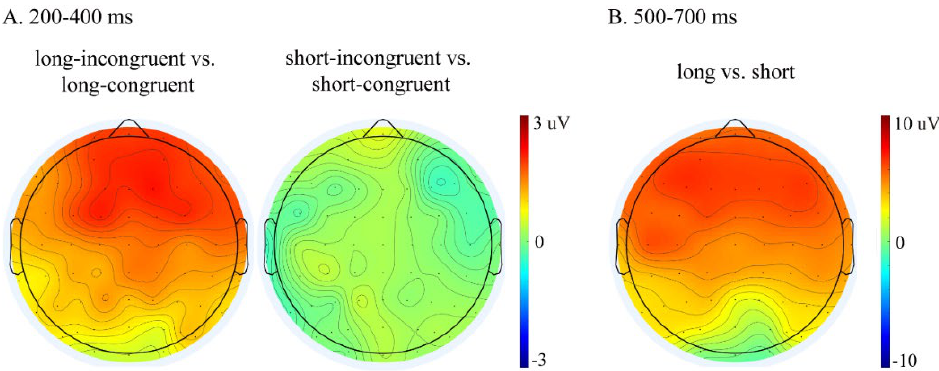
Figure 3. ( A ) Topographies of the difference waveforms determined by subtracting ERPs for the long–congruent conditions from those of the long–incongruent conditions (left) and by subtracting ERPs for the short–congruent conditions from those of the short–incongruent conditions (right) in the 200–400 ms time window. ( B ) Topographies of the difference waveforms calculated by subtracting ERPs for the short conditions (the average of the short–congruent and short–incongruent conditions) from those of the long conditions (the average of the long–congruent and long–incongruent conditions) in the 500–700 ms time window.